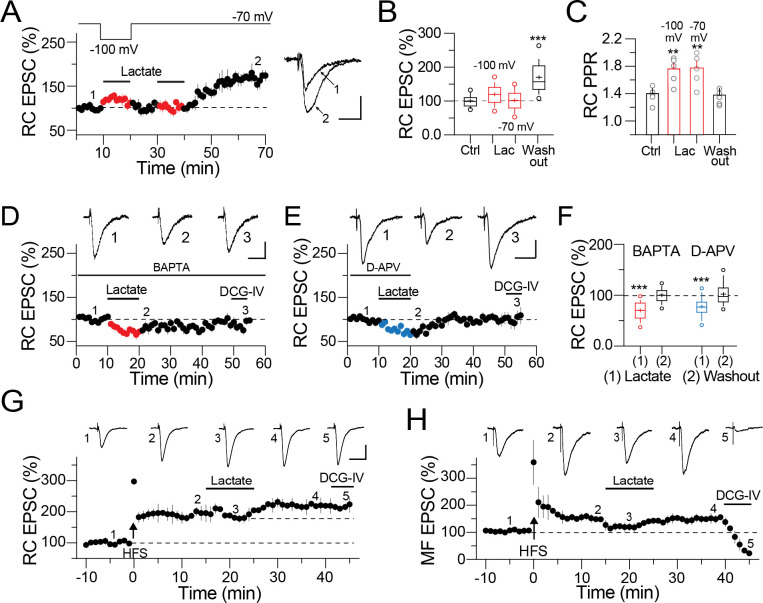
Postsynaptic requirements for synaptic potentiation of CA3 pyramidal cells.A) Averaged time-course graph; lactate (2 mM) was perfused while cells were held at -100 mV (red symbols). 5 min after washout, lactate perfusion with cells at -70 mV induced synaptic potentiation. Inset, representative RC EPSC obtained in control conditions (1) and 30 min after lactate washout (2). B) Boxplots summarizing the changes in the RC EPSC amplitude during baseline (solid box), lactate perfusion at -100 mV and -70 mV (red boxes) and at 30 min washout (solid line; One-way ANOVA on ranks, Tukey, ***p<0.001). C) RC PPR analysis at the indicated conditions (One-way ANOVA on ranks, Tukey, *p<0.05). D) Averaged time-course graph showing the effects of lactate in cells loaded with BAPTA (20 mM). The upper traces are representative RC EPSC (averaged from five continuous sweeps, acquired at the indicated time in the time-course graph). E) Averaged time-course graph and representative traces showing the effect of lactate in the presence of D-APV (50 μM). F) Boxplots summarizing the changes in the RC EPSC amplitude during lactate perfusion and at 30 min for the experiments performed with BAPTA or D-APV (One-way ANOVA on ranks, Tukey, ***p < 0.001). G) Averaged time-course graph and representative RC EPSC (averaged from five continuous sweeps, acquired at the indicated time in the time-course graph) in response to SR HFS (100 Hz, repeated 3 times, 10 sec interval) showing that lactate (2 mM for 10 min) triggers additional synaptic potentiation. H) Averaged time-course graph and representative MF EPSC (acquired at the indicated time in the time-course graph) in response to stratum lucidum HFS (100 Hz, repeated 3 times, 10 sec interval) showing that lactate (2 mM for 10 min) causes transient depression without affecting the magnitude of MF LTP upon lactate removal. Calibration bars for panel A, 20 pA / 25 ms; for panel D and E: 25 pA / 25 ms; for panel H and G, 50 pA / 50 ms.